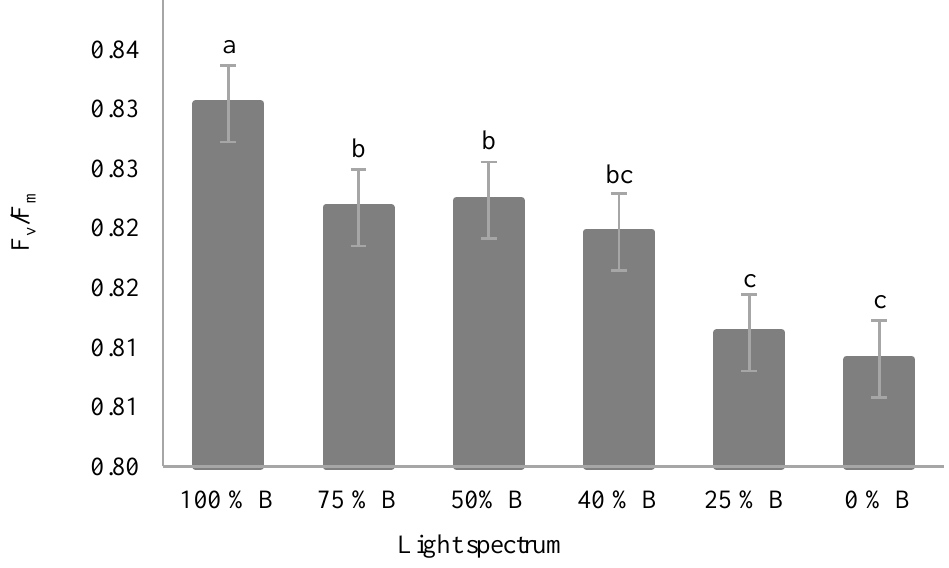
Figure 5. The maximum quantum yield of PSII (F v /F m ; equation in Table 1) of saffron plants grown under different ratios of Blue (B) to Red (R) light in the overall spectral composition, including 100% B, 75% B, 50% B, 40% B, 25% B, 0% B (see the spectra in Figure 1), with 150 ± 10 µ mol m − 2 s − 1 PPFD. Different letters indicate that values are significantly different at p < 0.01 according to Duncan’s multiple range tests. Bars represent mean value ± standard